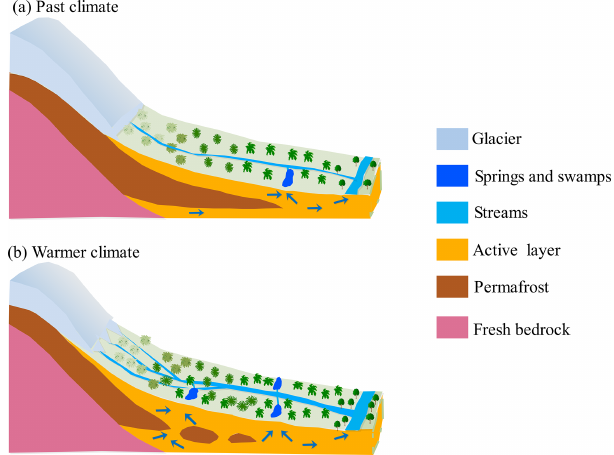
Figure 3. Diagram depicting the changes in surface water, ground- water and active groundwater storage due to glacier melt and per- mafrost thawing under (a) past climate and (b) a warmer